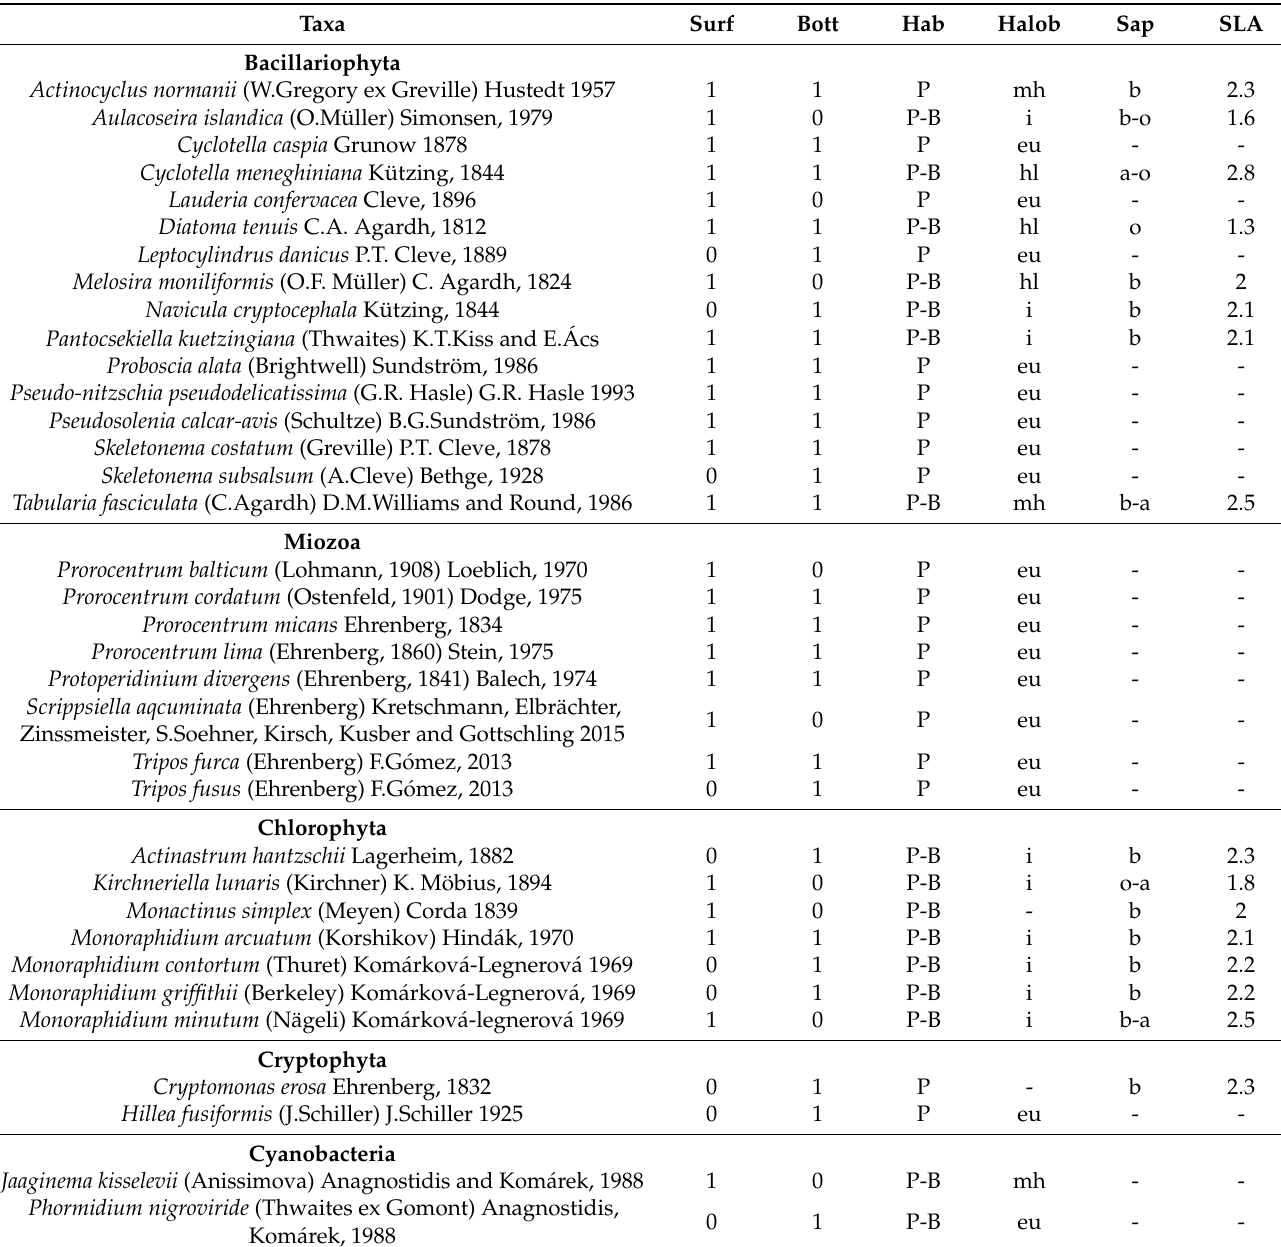
Table 3. List of species in the phytoplankton in the Ukrainian part of Danube nearshore area in August 2018 with some ecological